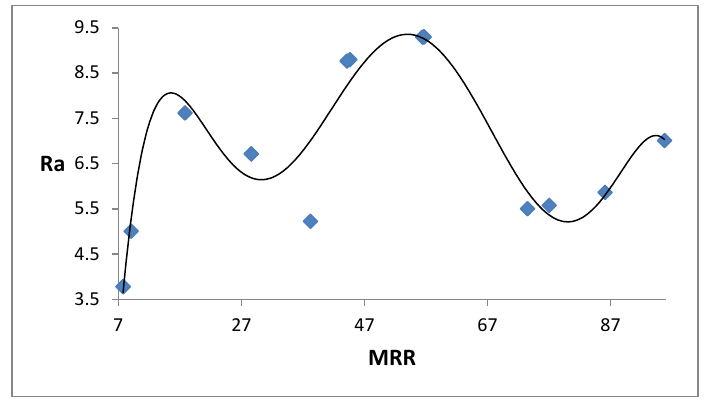
Figure 17. Pareto front between MRR and R a .